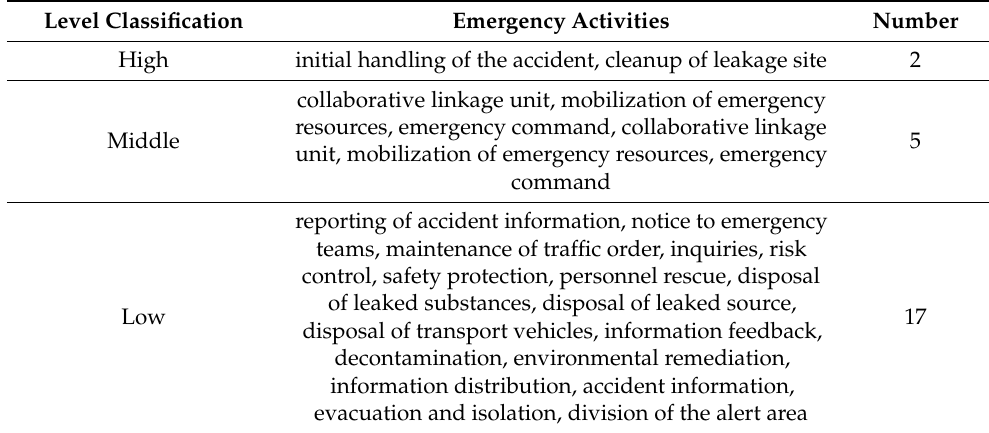
Table 10. Human error level